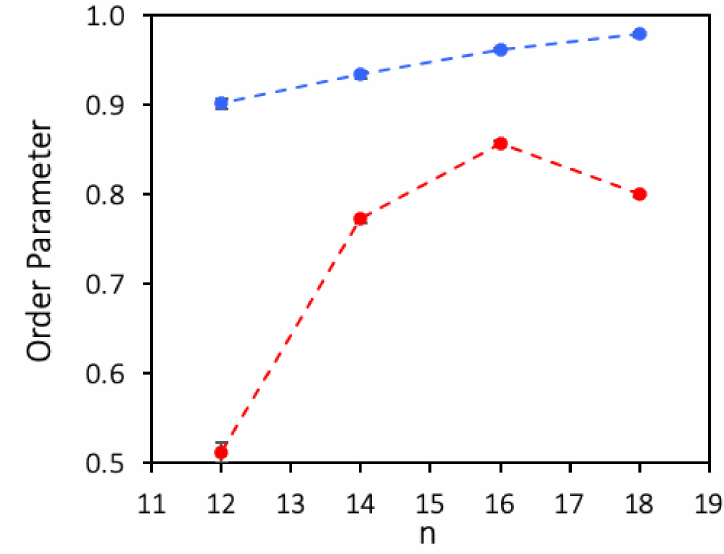
Figure 7. Simulated Average Order Parameter ( (cid:99) OP) for Langmuir films at the surface of water of several fluorinated alcohols, F12OH, F14OH, F16OH and F18OH, and hydrogenated alcohols, H12OH, H14OH, H16OH and H18OH. All films contain 550 molecules at 0.6 nm 2 / molecule. The dashed lines are guides to the eye.